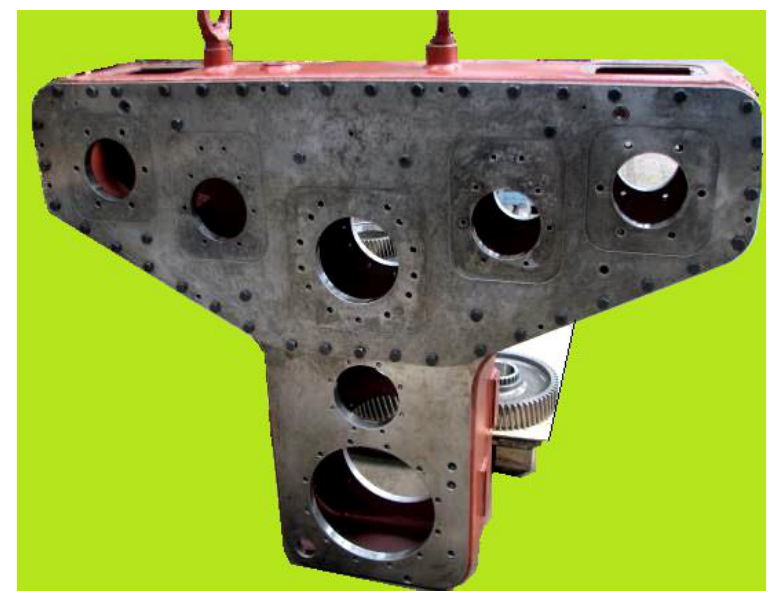
Figure 3. Adder box housing before mounting the covers and gears.